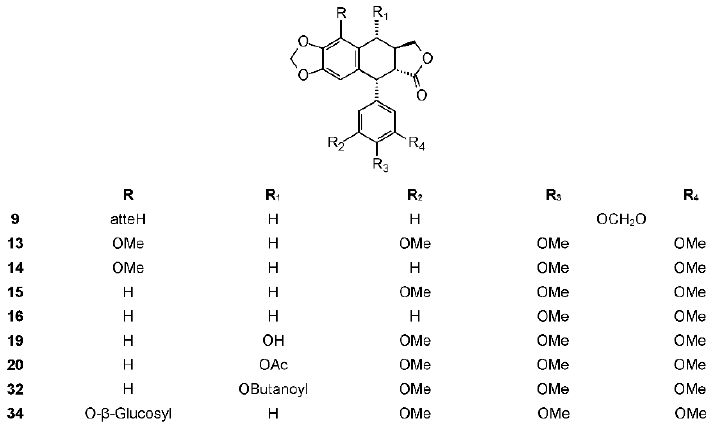
Figure 3. Aryltetraline lignans isolated from Bursera spp.